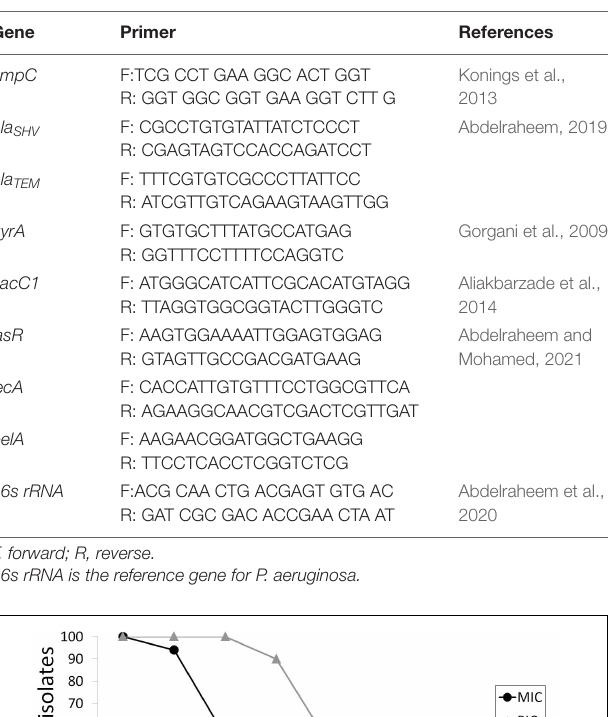
TABLE 1 | Sequence of primers used for